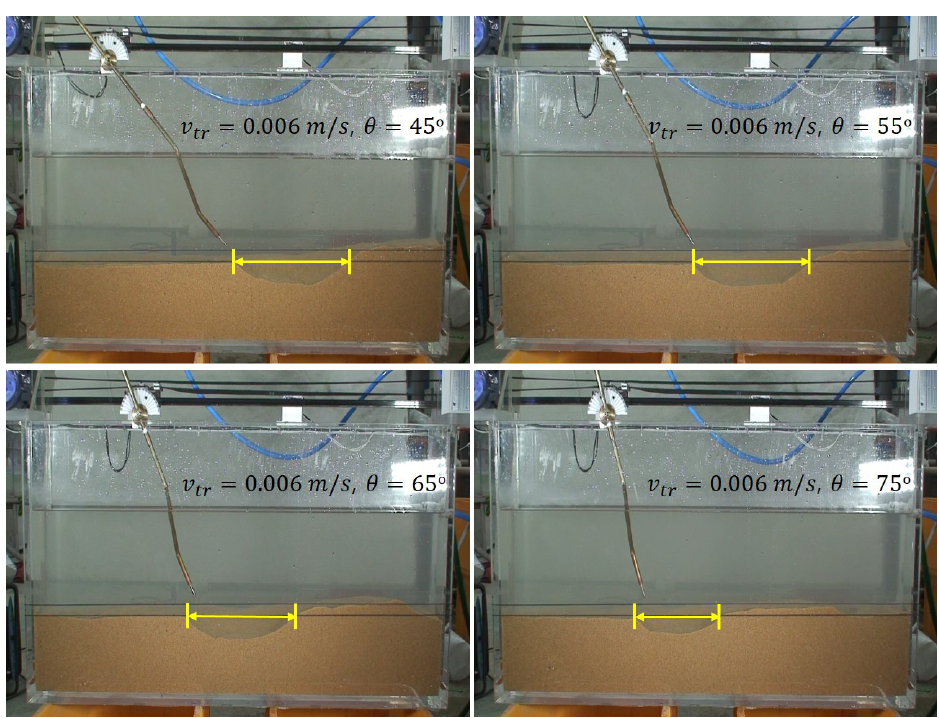
Figure 6. Trench entrance becomes narrower with increasing jetting